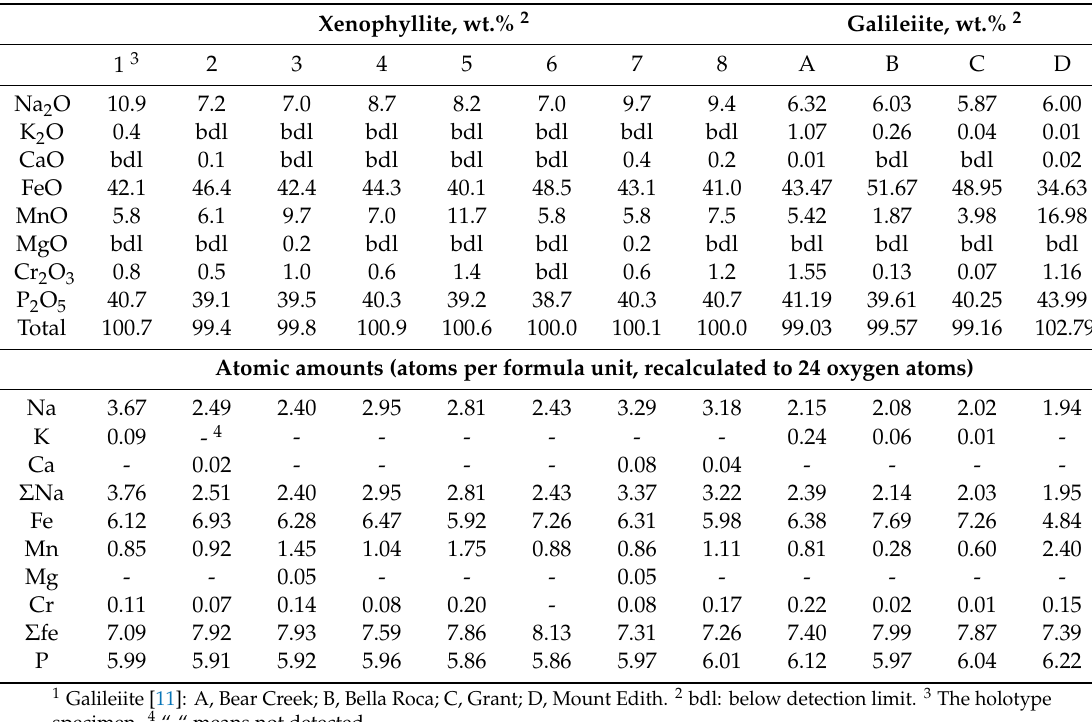
Table 5. Chemical composition of xenophyllite from the Augustinovka meteorite (analyses 1–8, our data) and galileiite from selected IIIAB iron meteorites (analyses A–D) 1 .